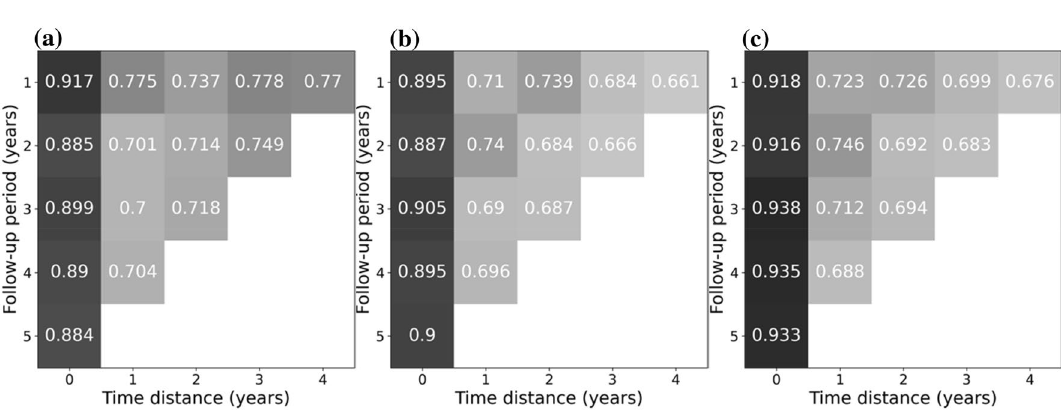
Figure 4. Specificity for predicting death using Logistic regression ( a ), Random forests ( b ) and Extreme Gradient Boosting ( c ). Models built on different follow-up periods (from 1 to 5 years) in which covariates may have occurred, and used different time distances (time between exposure and event